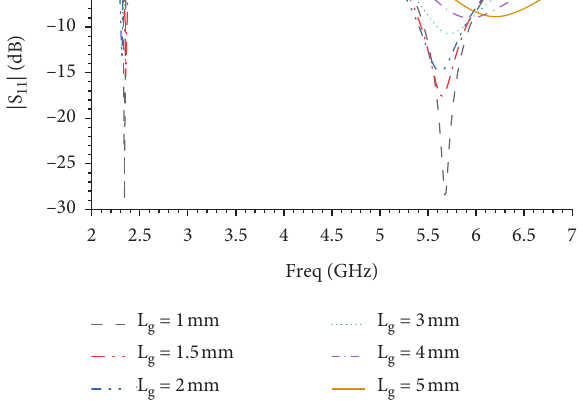
Figure 5: S11 variation due to L